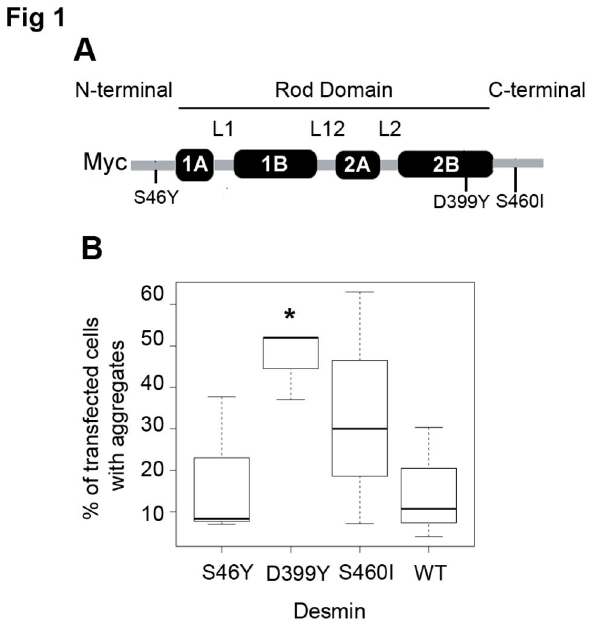
Figure 1. Mutation locations within desmin structure and transient desmin aggregation rates. ( A ) Tripartite desmin representation with S46Y mutation in N-terminal Domain, D399Y in Rod Domain, and S460I in C-terminal Domain. Desmin is Myc-tagged at its N-terminus. ( B ) C2C12 cells transient transfected with plasmids encoding the desmin WT or mutants were stained for immunofluorescence of desmin. Quantification of transfected cells containing aggregates in box plot was performed on three independent experiments. Significant differences are indicated with asterisk (p<0.05) calculated with non-parametric